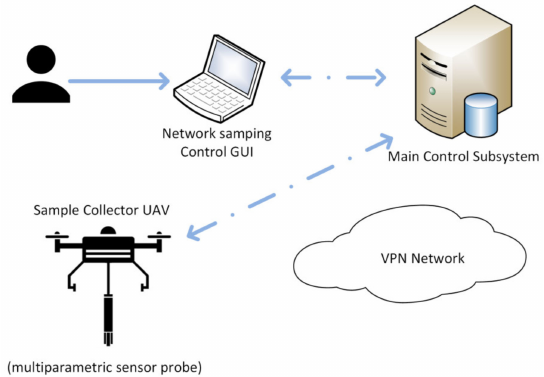
Figure 1. Virtual sensor network using a multiparametric probe. The user interfaces through a remote interface (with a graphical user interface, GUI) with the control system, to designate the sampling operations parameters, all in a Virtual Private Network, VPN. The control system uses these input to relay the mission data to the sampling unmanned aerial vehicle (UAV). In this case, the results can be notified even before the UAV.